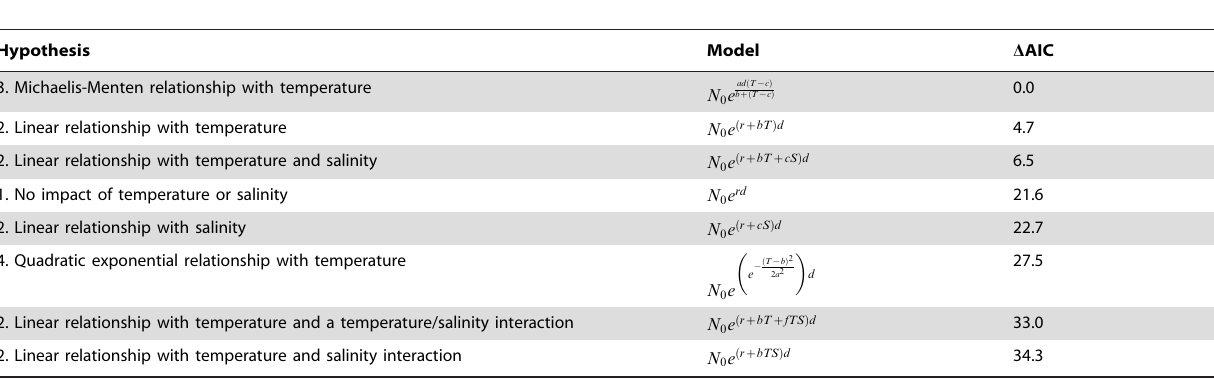
Table 1. The results of the model comparison; the number before each hypothesized relationship corresponds with a specific hypothesis given in the introduction.